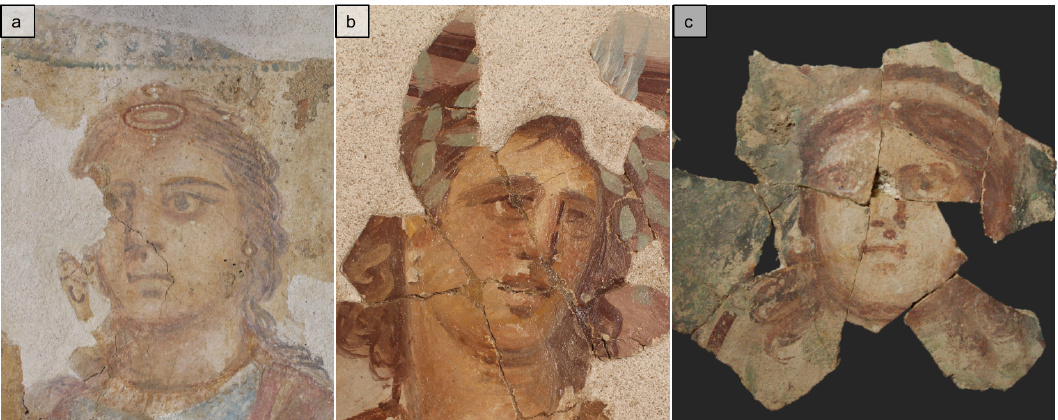
Figure 21. ( a ) From Tomb 3510, a funerary figurative painting exhibits fine brush strokes with juxtaposition of different colors in small details such as the eyebrows and hair and the blending of ochres to produce naturalistic shading in the face are a testament to the skill of the artist (I); ( b ) From the House of Aion, a figurative painting features extensive color mixing and shading to produce multiple tones in the skin and a heavy skiagraphia effect (E9); ( c ) A funerary figurative painting from the tomb in the Costis Palamas square shows a simpler depiction of facial features; there is less skin tone variation than the other two figures, and shading mostly appears with the application of a red wash around the face